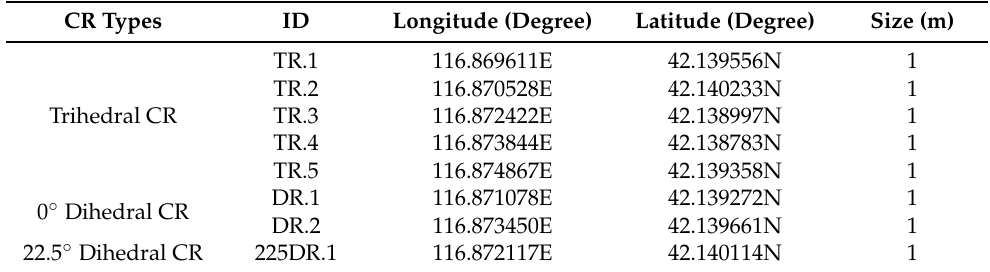
Table 2. Summery of the CRs. N and E of columns 3 and 4 are north latitude and east longitude, respectively. Detailed schematic diagrams of the CR sizes can be referred to Figure